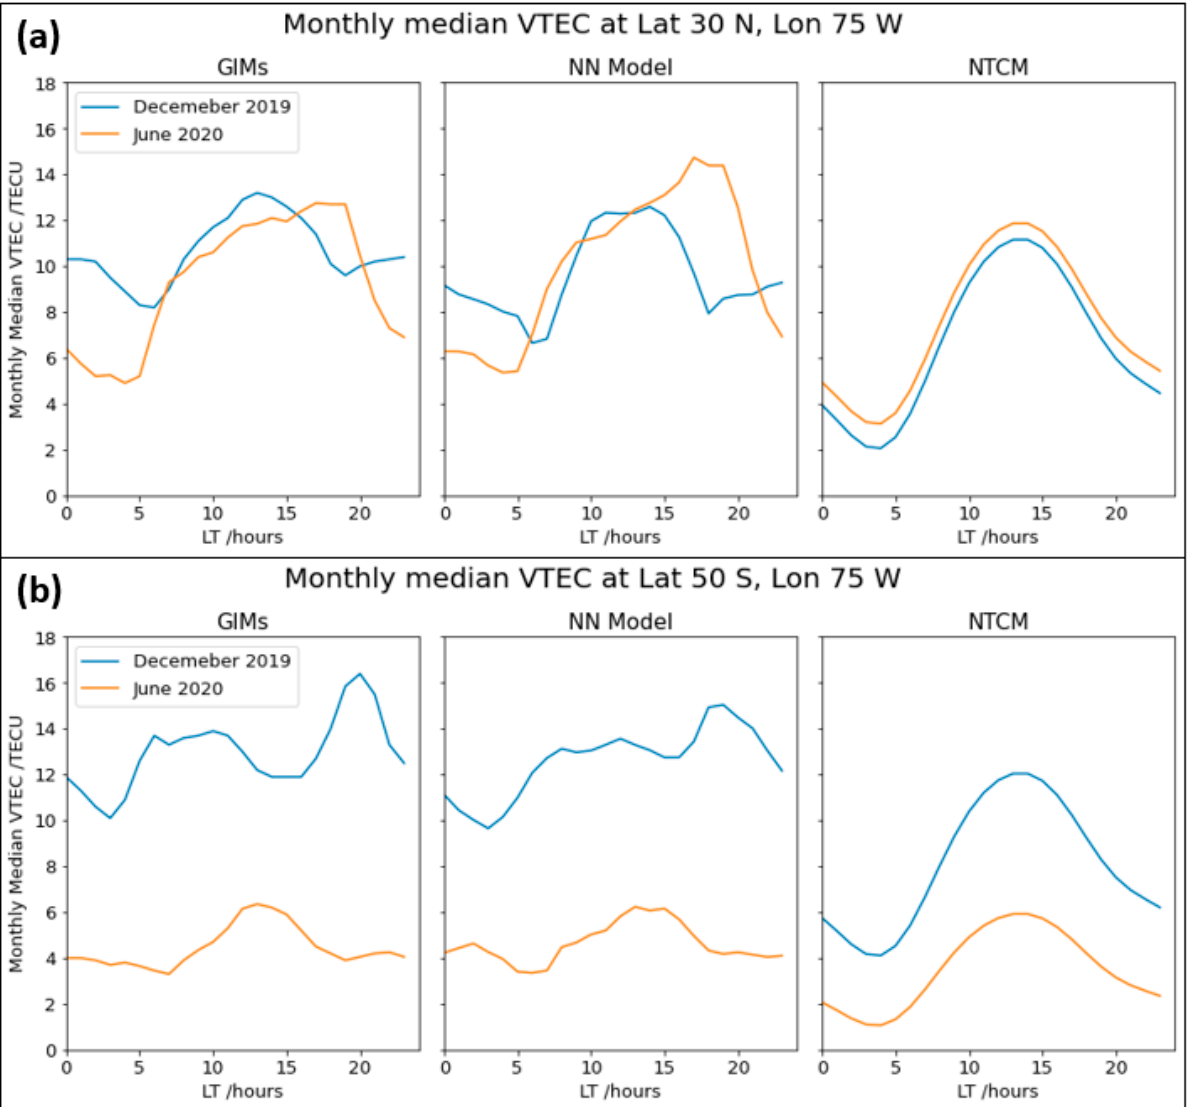
Figure 6. Monthly median VTEC plotted against LT for the Northern Hemisphere’s Nighttime Winter Anomaly (NWA) for the American sector ( a ) and at the conjugated location ( b ).